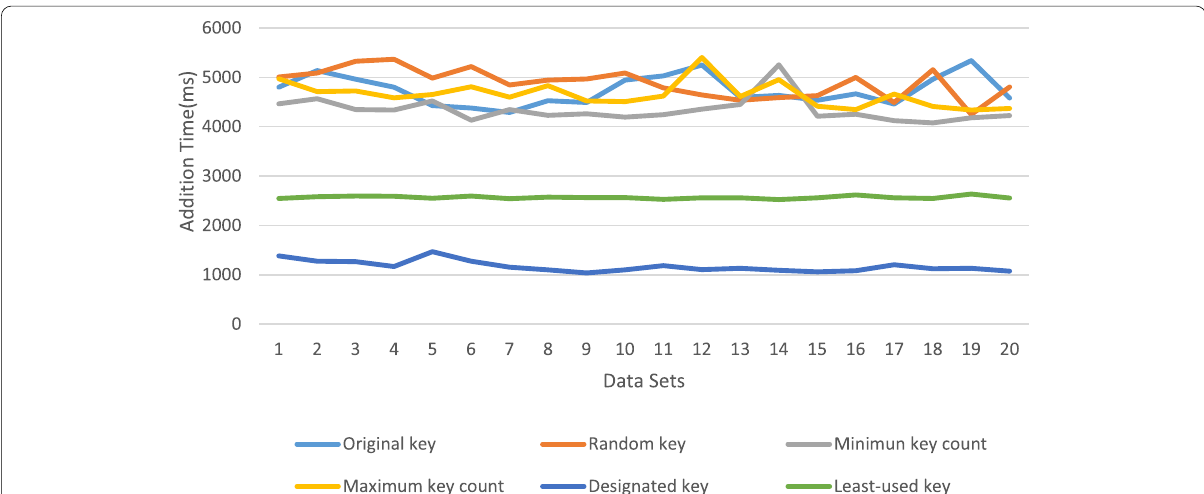
service retrieval requests